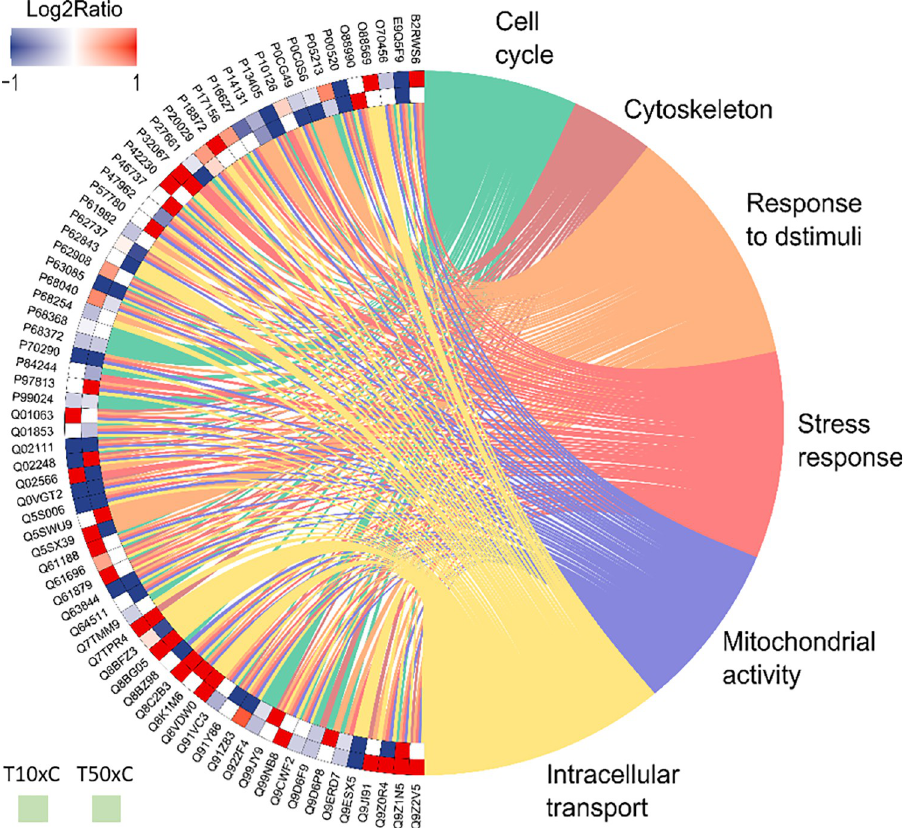
Fig 6. Enrichment analysis. Over-represented proteins in the parotid glands of mice (n = 30, 10 per group) exposed for 60 days to F concentrations: 10 mg/L of F vs . control (T10xC) and 50 mg/L of F vs . control (T50xC). Protein categories based on the gene ontology (GO) selected for biological processes, cellular component and molecular function. The external and internal protein sequences represent the comparisons between T10xC and T50xC, respectively. The color indicates the differential expression of each protein, that is represented with its access code. Red indicates overexpression and blue, down-regulation. The tonality varies according to the intensity of down or up regulation status. According to the Uniprot database, the access numbers of the proteins over and under-represented correspond to: Histone acetyltransferase p300 (B2RWS6), Histone-lysine N-methyltransferase SETD2 (E9Q5F9),